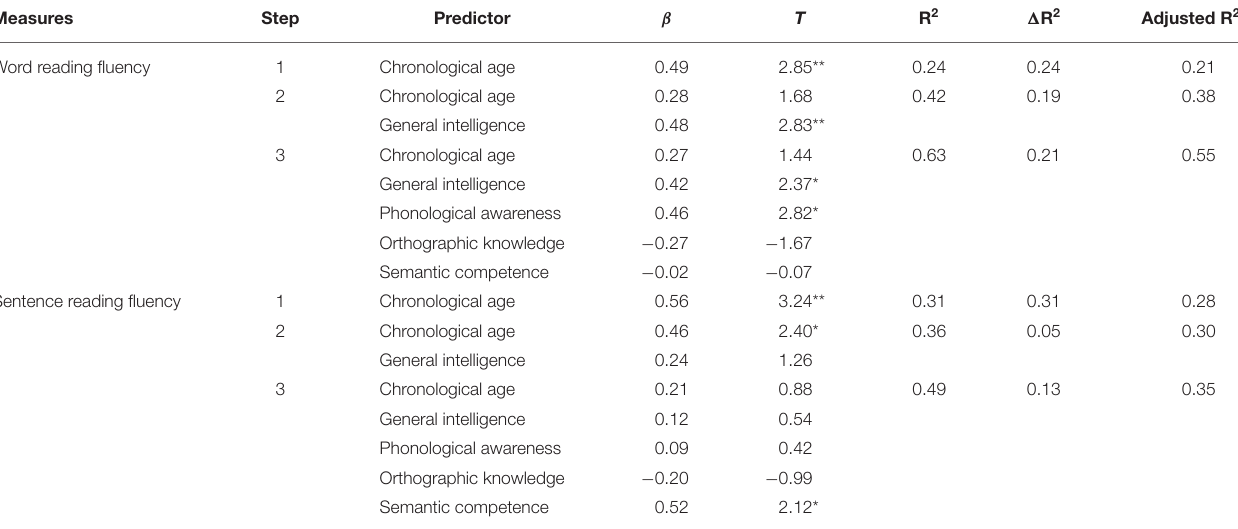
TABLE 4 | Hierarchical multiple regressions predicting word reading fluency and sentence reading fluency for children with NH.